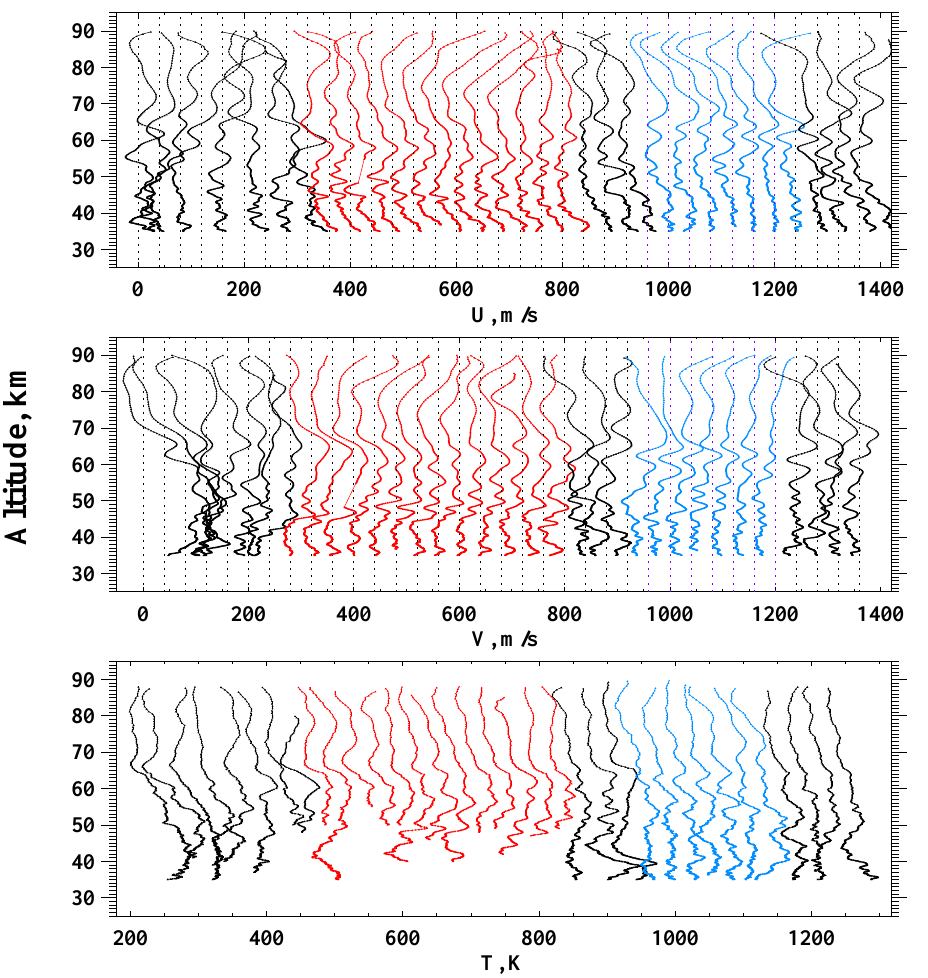
Fig. 1. Waterfall plots of falling sphere zonal and meridional winds (the upper two panels) and temperature raw soundings (the lower panel) over Esrange, Sweden (67.9 ◦ N, 21.1 ◦ E) during the MaCWAVE winter campaign. Soundings in Salvo 1 are marked in red, whereas those in Salvo 2 are marked in blue. The horizontal spacing of adjacent profiles is 40ms − 1 for winds and 30K for temperature. Temporally adjacent profiles are plotted with equal spacing regardless of the actual time difference. The temporal resolution of the soundings was generally 1 or 2 days, except during Salvo 1 and 2, for which the resolution was ∼